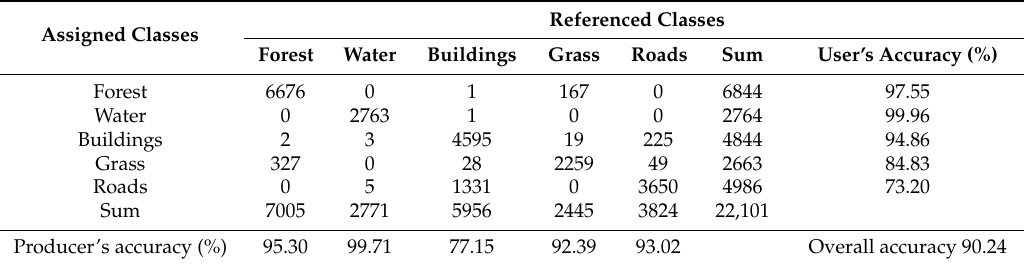
Figure 7. LULC classification results: ( a ) based on the original training data set; and ( b ) based on the bootstrap training data sets and the highest class probability. The purple-circled area is the main structure of the Beitou Depot of the Taipei MRT (see Section 4.2.3). ( c , d ) Magnified images of the red-square-enclosed areas in Panels ( a ) and ( b ), respectively. Table 3. Confusion matrix of LULC classification by using the original training data set.